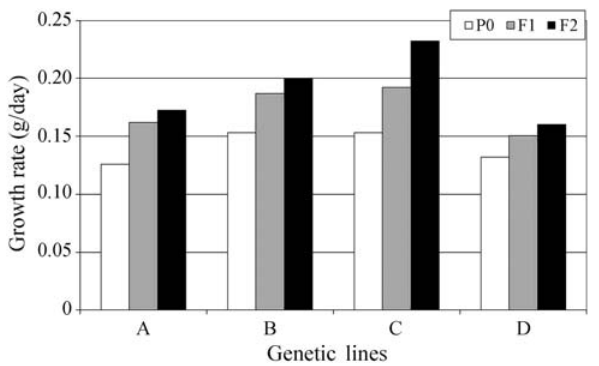
Figure 2 - Mean growth rate for all Litopenaeus vannamei families per generation in the four genetic lines studied.